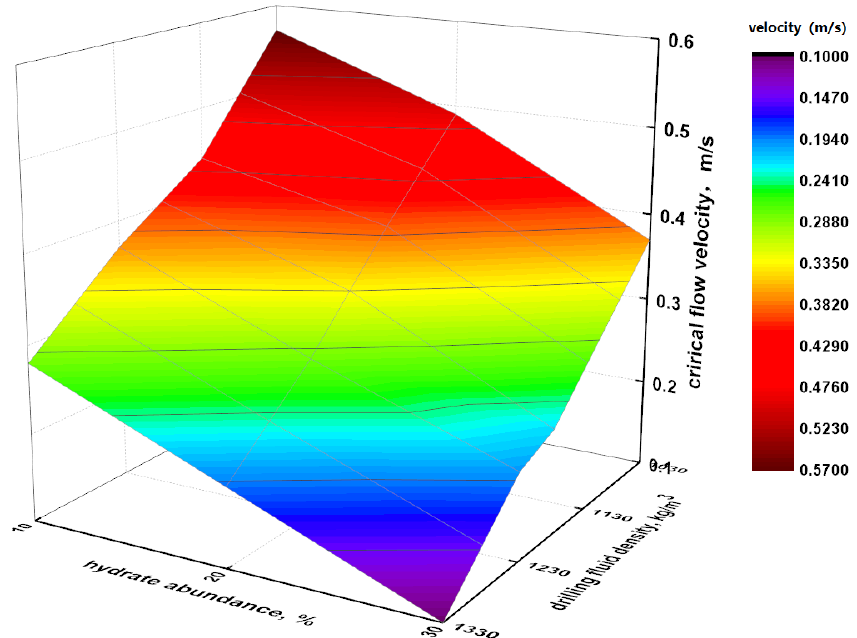
Figure 12. The critical flow velocity plate of di ff erent hydrate abundance and drilling fluid density under arc expansion.